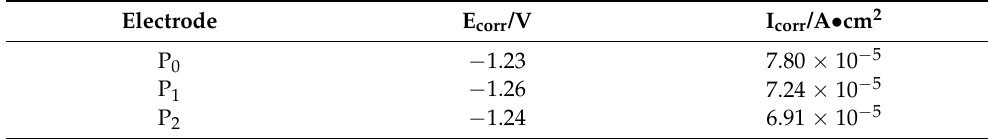
Table 2. Electrochemical